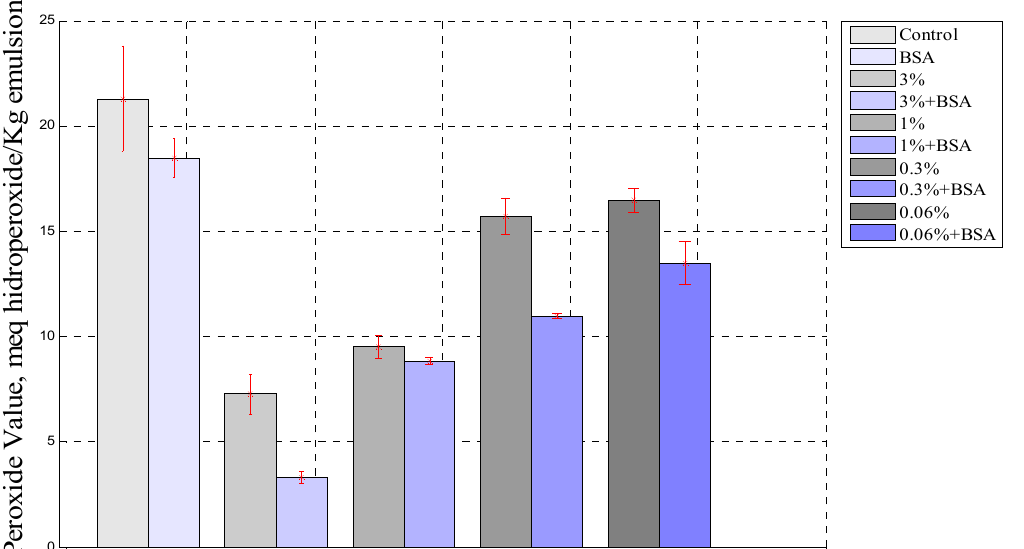
Figure 4. Comparison between samples containing extract and extract plus BSA at 864